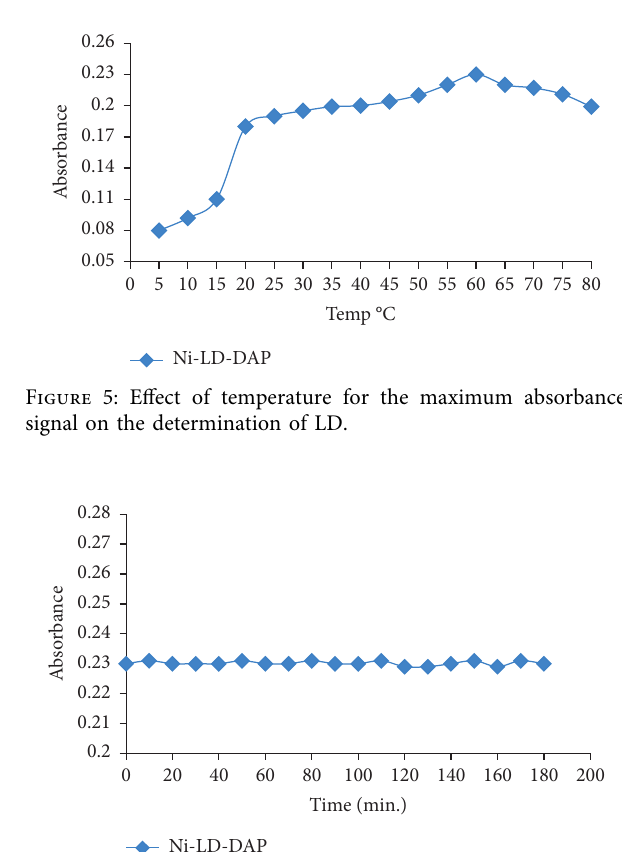
Figure 6: Effect of time per min on the maximum absorbance signal of